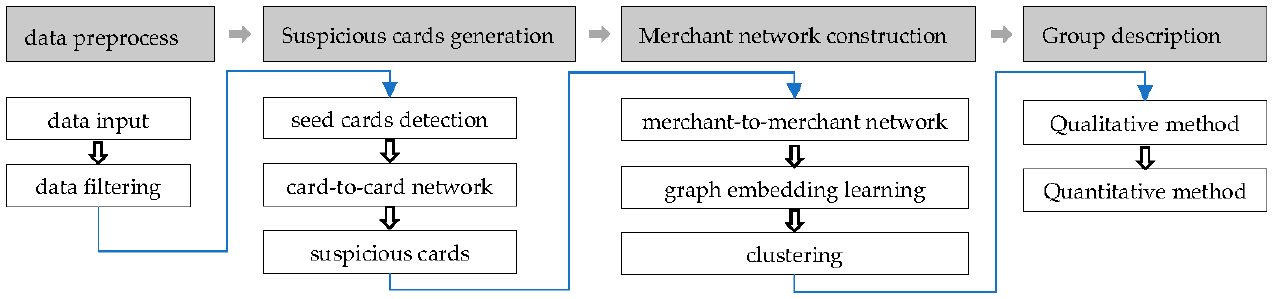
Figure 1. Flow chart of model setup.